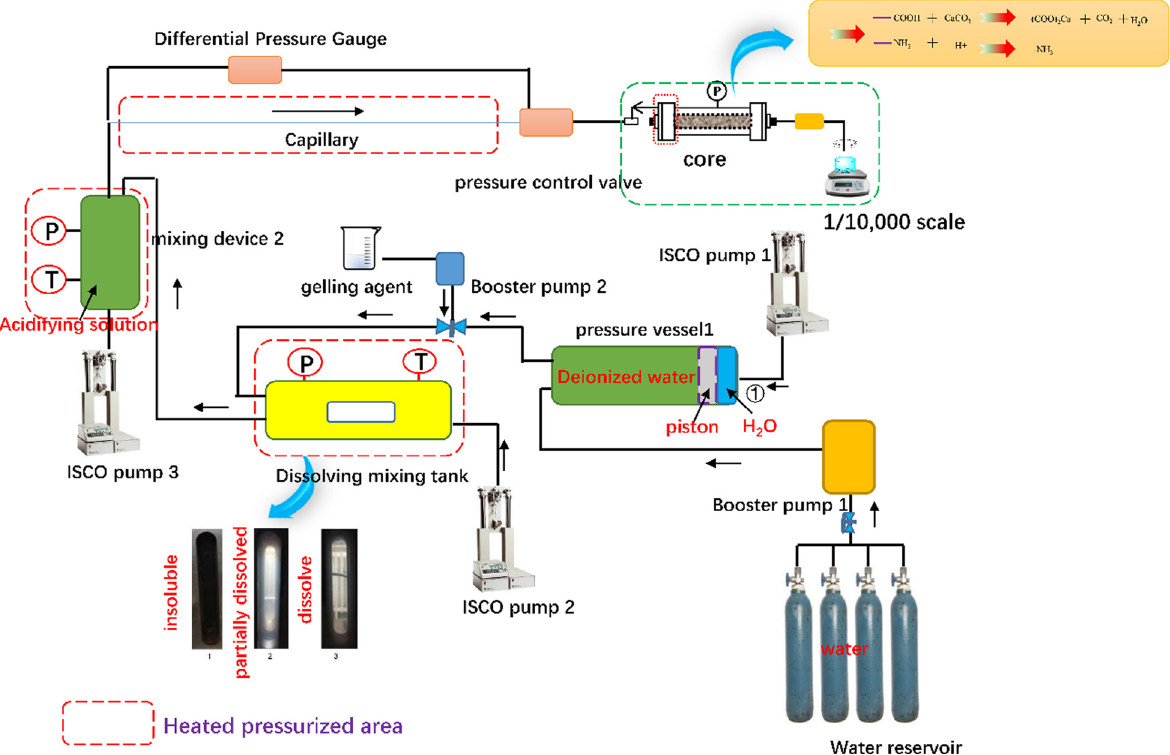
Figure 1: Experimental evaluation device and schematic diagram of acid rheology and fi ltration